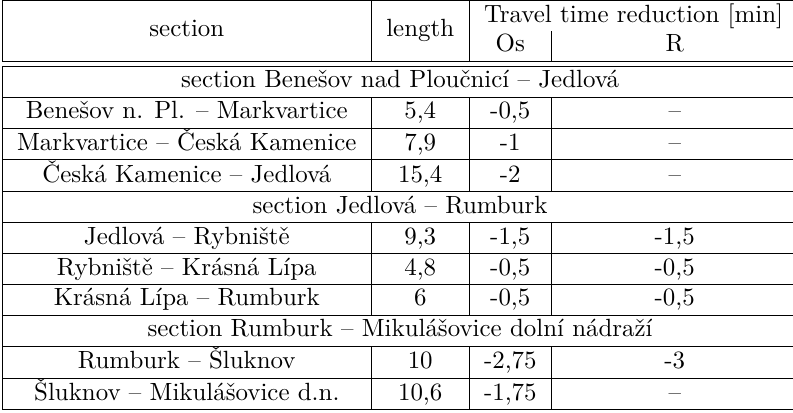
Table 1. Travel time reduction on individual sections.